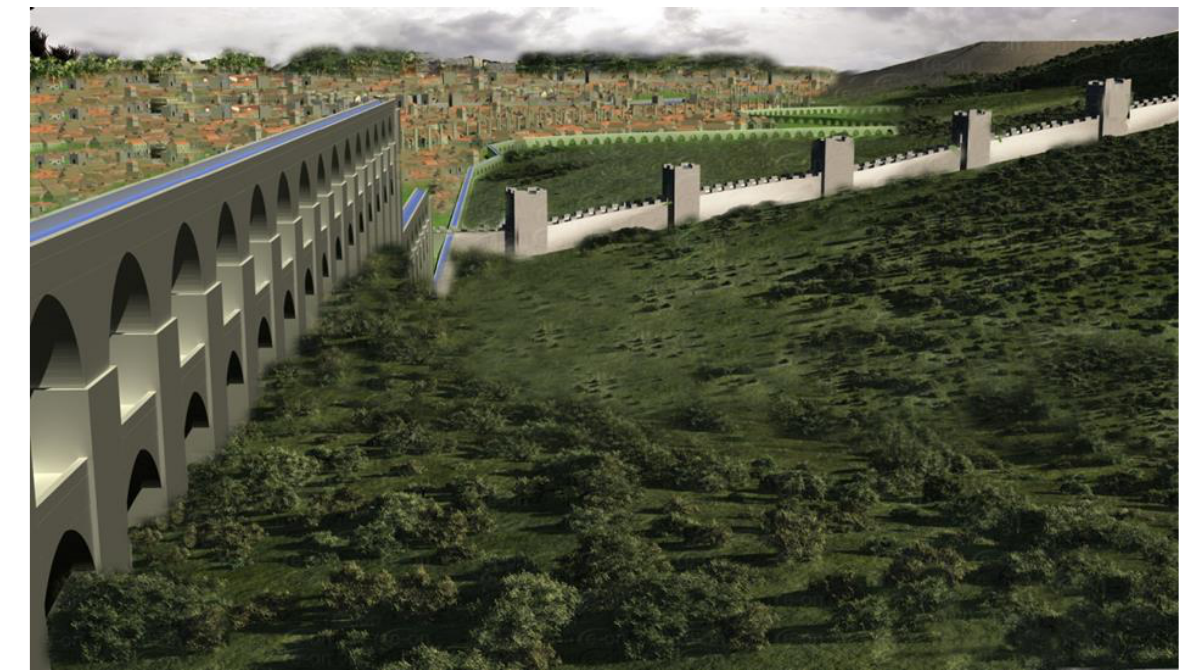
Figure 9. Ancient Antioch’s modeled aqueducts from the Daphne waterfalls .